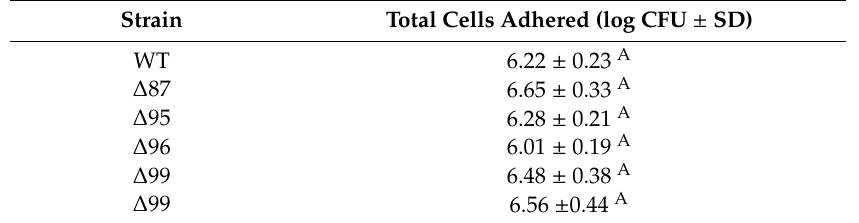
Table 3. Caco-2 cell adherence of S. Agona strains. The adherence assay was conducted in triplicate and are represented as means ± SD. Means of the BIMs were compared to that of the WT. Di ff erent letters indicate significance below α =